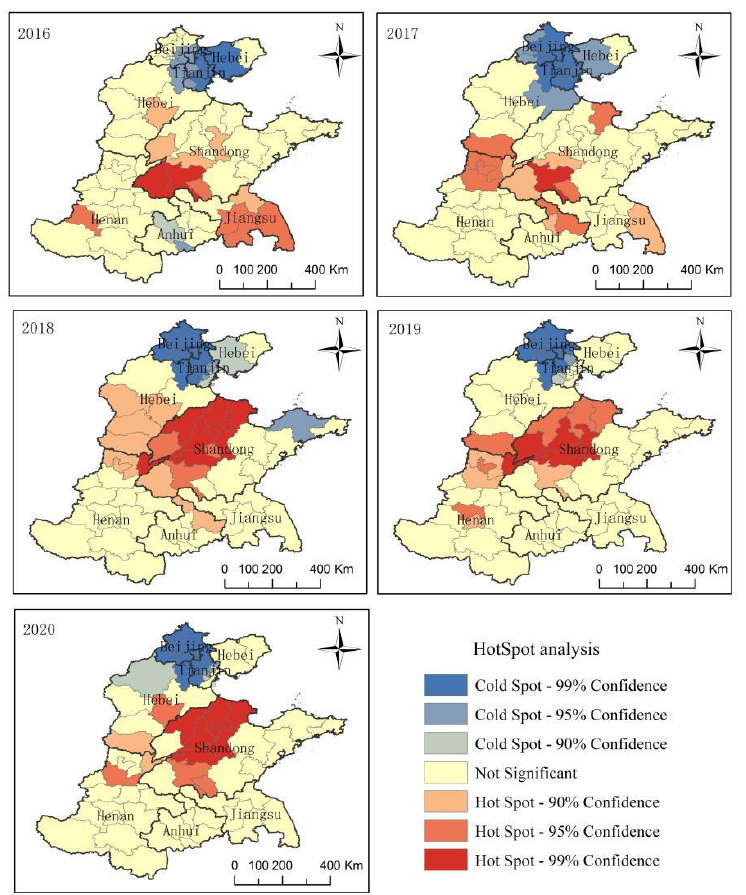
Figure 3. Spatial aggregation characteristics of O 3 concentrations in the NCP from 2016 – 2020.